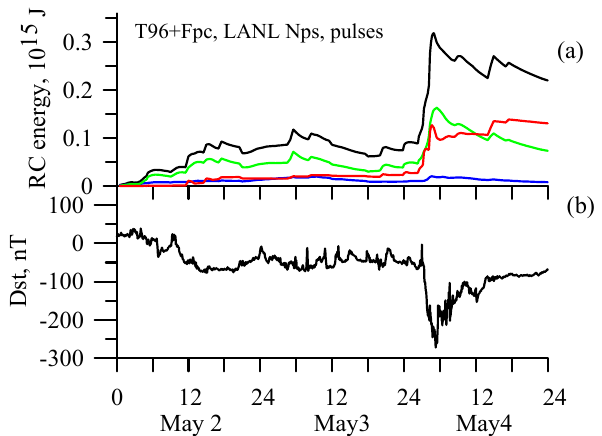
Fig. 10. Calculated proton ring current energy in Joule ( a ) for four energy ranges such as the total (1–200keV, black curves), the low (1–20keV, blue curves), the medium (20–80keV, green curves) and high energies (80–200keV, red curves) and the measured D st index ( b ) for modelled period of 2–4 May 1998 when several electromag- netic pulses were activated at the substorm